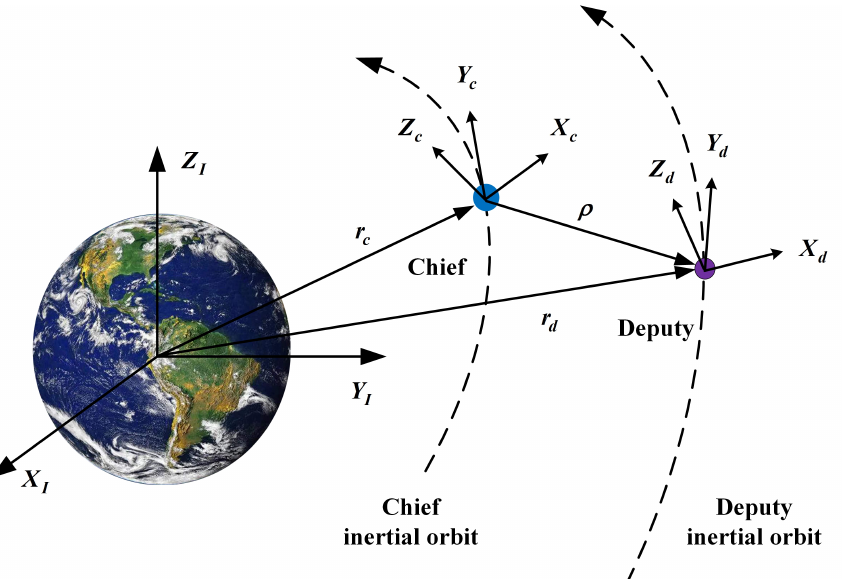
Figure 5. Definition of related coordinate